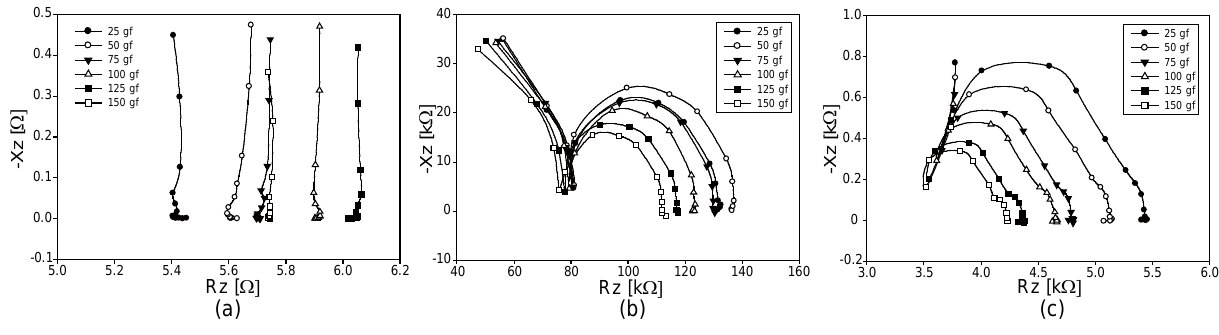
Figure 8. Argand diagrams of the impedance spectra from three conductive fabrics under tension. ( a ), ( b ), and ( c ) are from the fabrics A, B, and C, respectively.